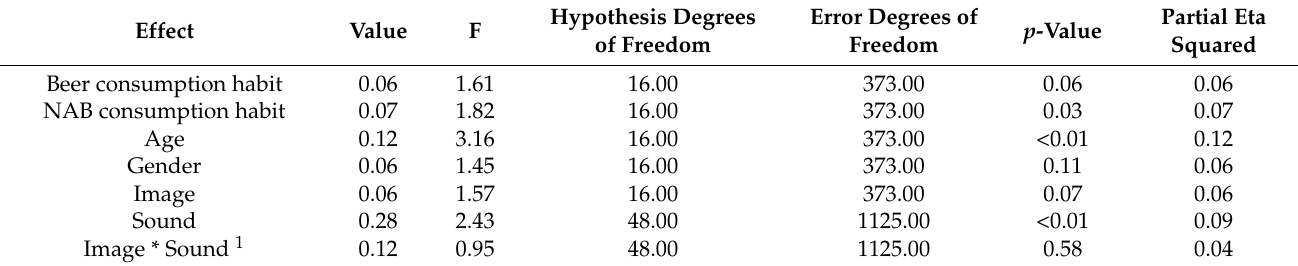
Table 5. Summary of the results of the Pillai’s Trace multivariate tests for the emotion scores in Experiment 2. Effect